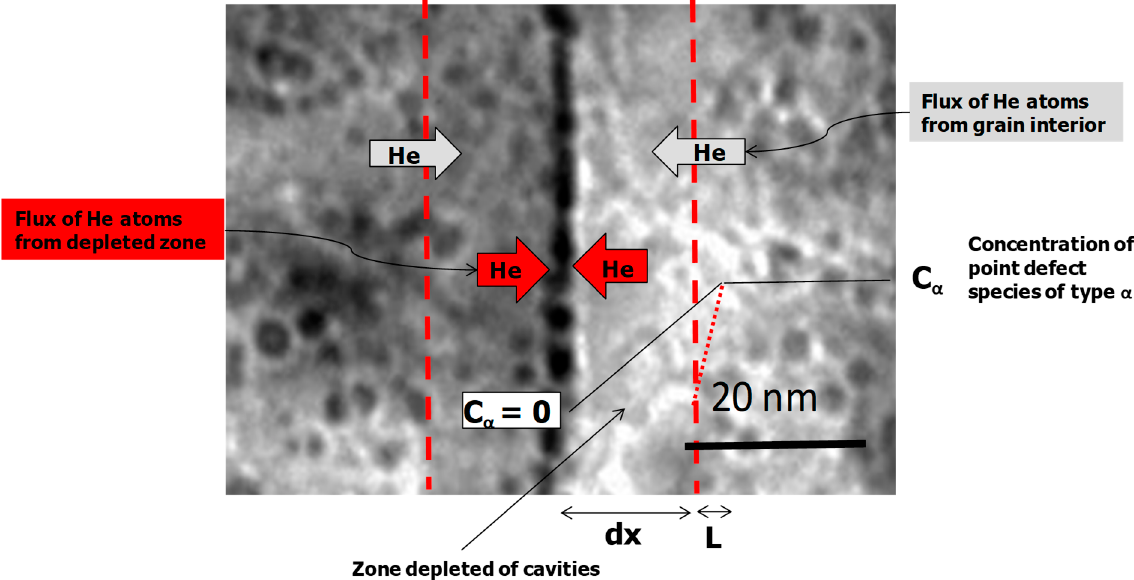
Figure 11. Diagram illustrating source of He flow to grain boundaries. Half of the He generated in the denuded zone is assumed to migrate to the grain boundary and half migrates into the grain interior. The He flux from the interior is equivalent to the He flux to the boundary that would exist in the absence of a denuded zone; this flux to the boundary is reduced by the presence of the denuded zone.